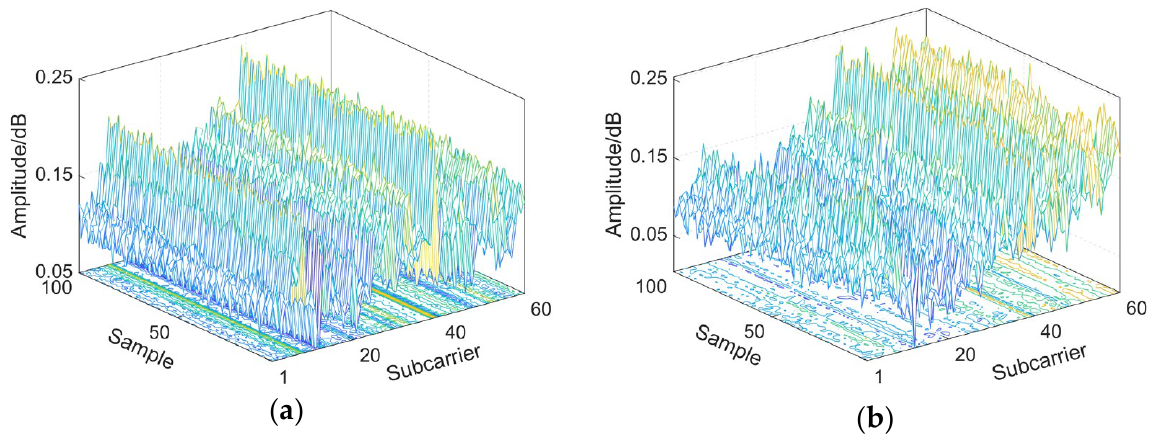
Figure 2. 3D images of CSI data collected at different locations. ( a ) Location A. ( b ) Location B.